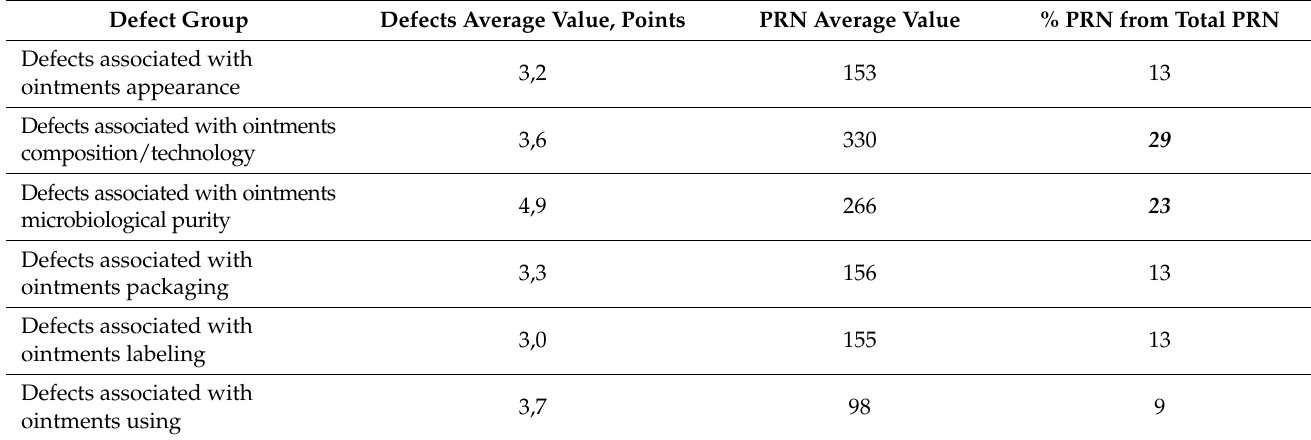
Table 2. Calculated characteristics of defect groups (for all